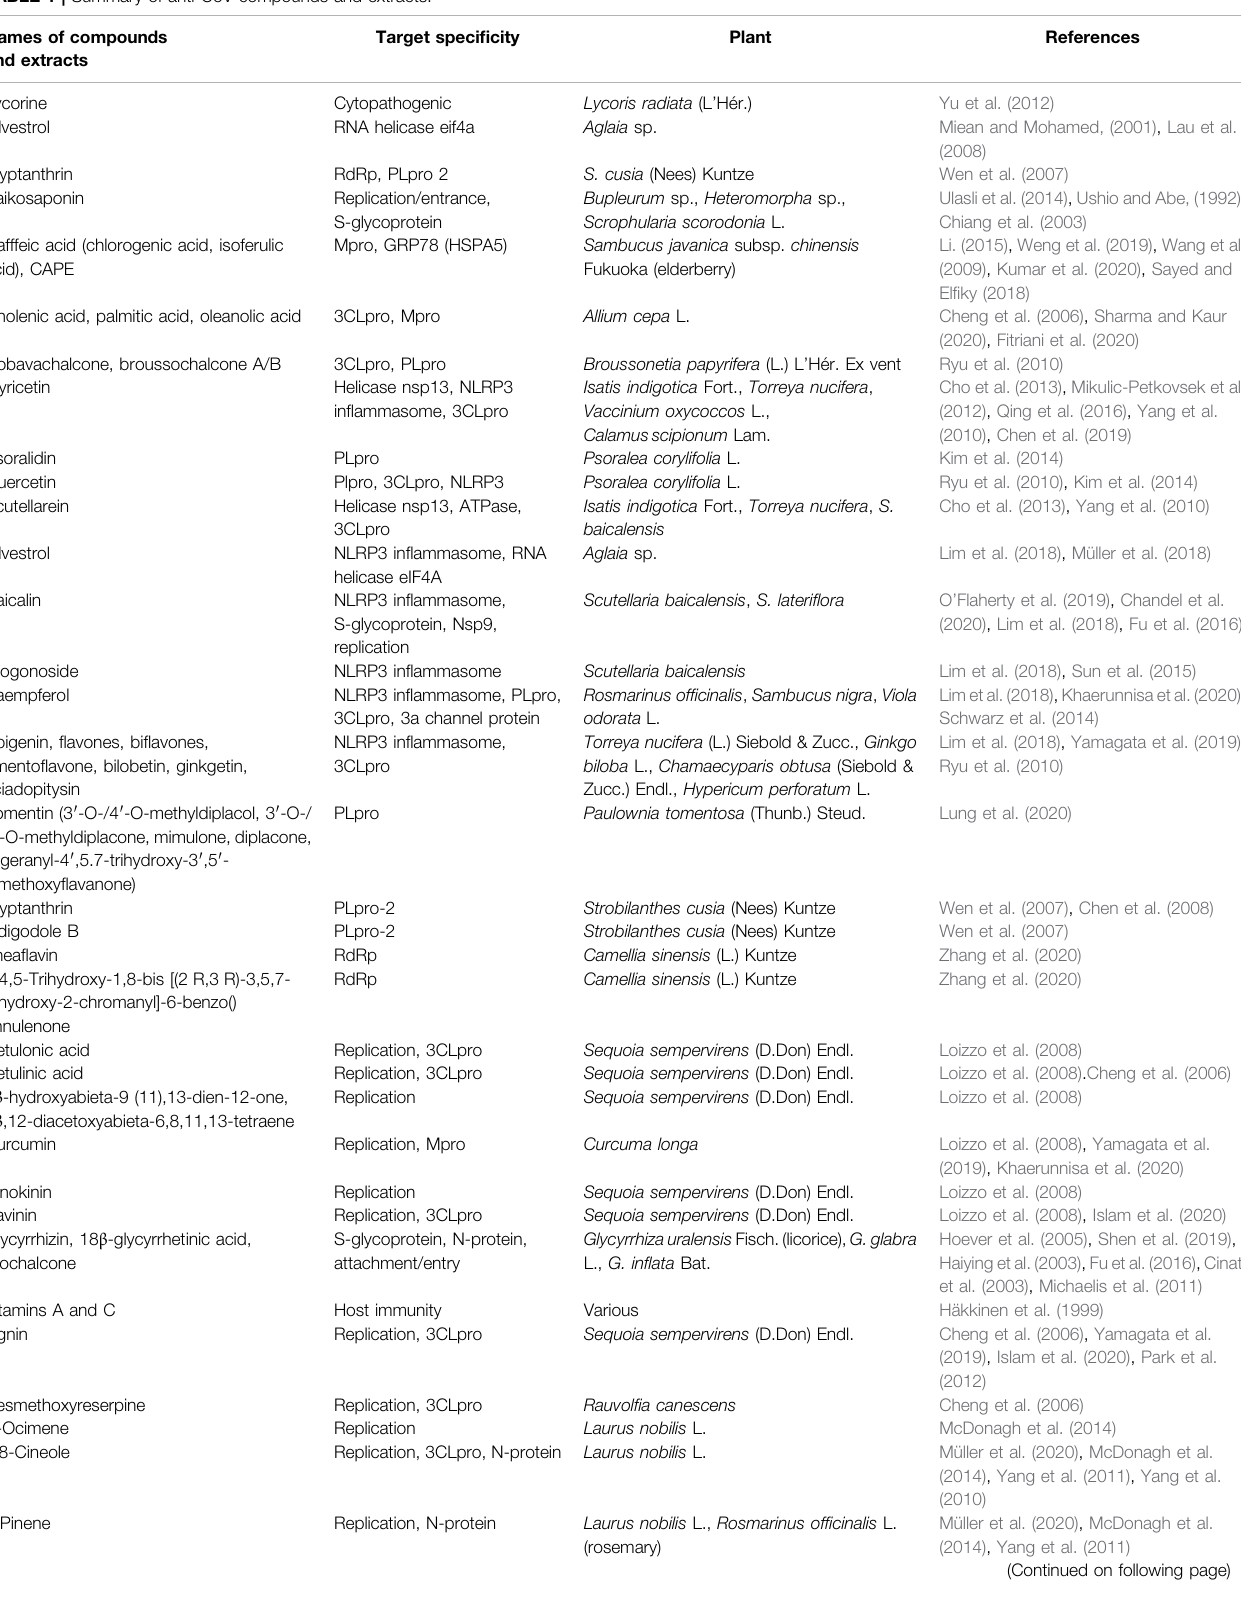
TABLE 1 | Summary of anti-CoV compounds and